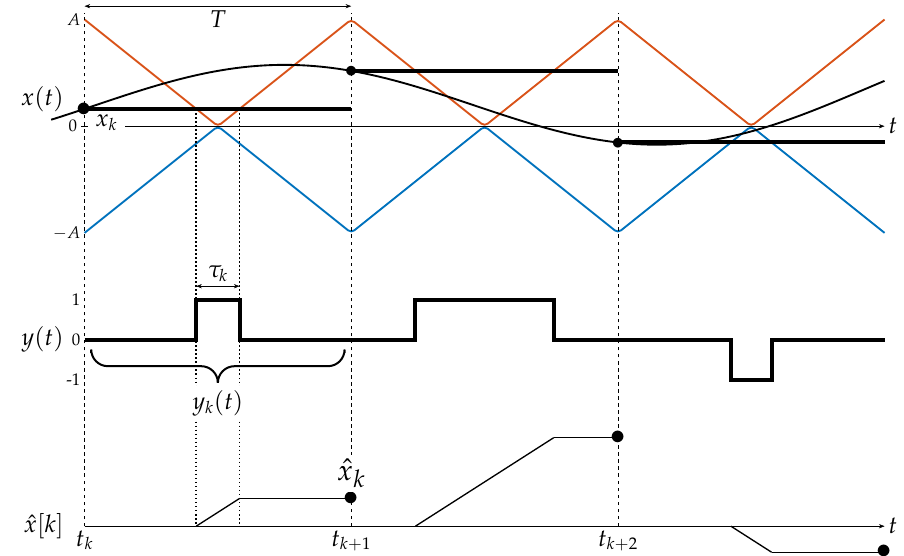
Figure 2. Examples of 3-level PWM signals. From top to bottom: input signal x ( t ) together with the two triangular reference waveforms, the M-PWM signal y ( t ) , and the estimated sample amplitude ˆ x k after PW